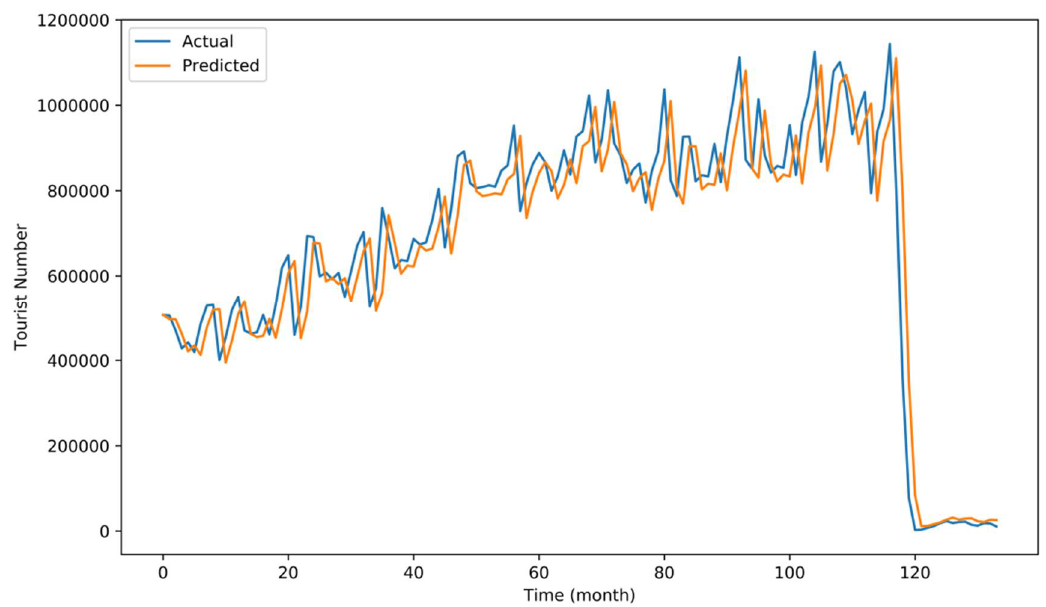
Figure 6. Actual data vs. prediction for LSTM.